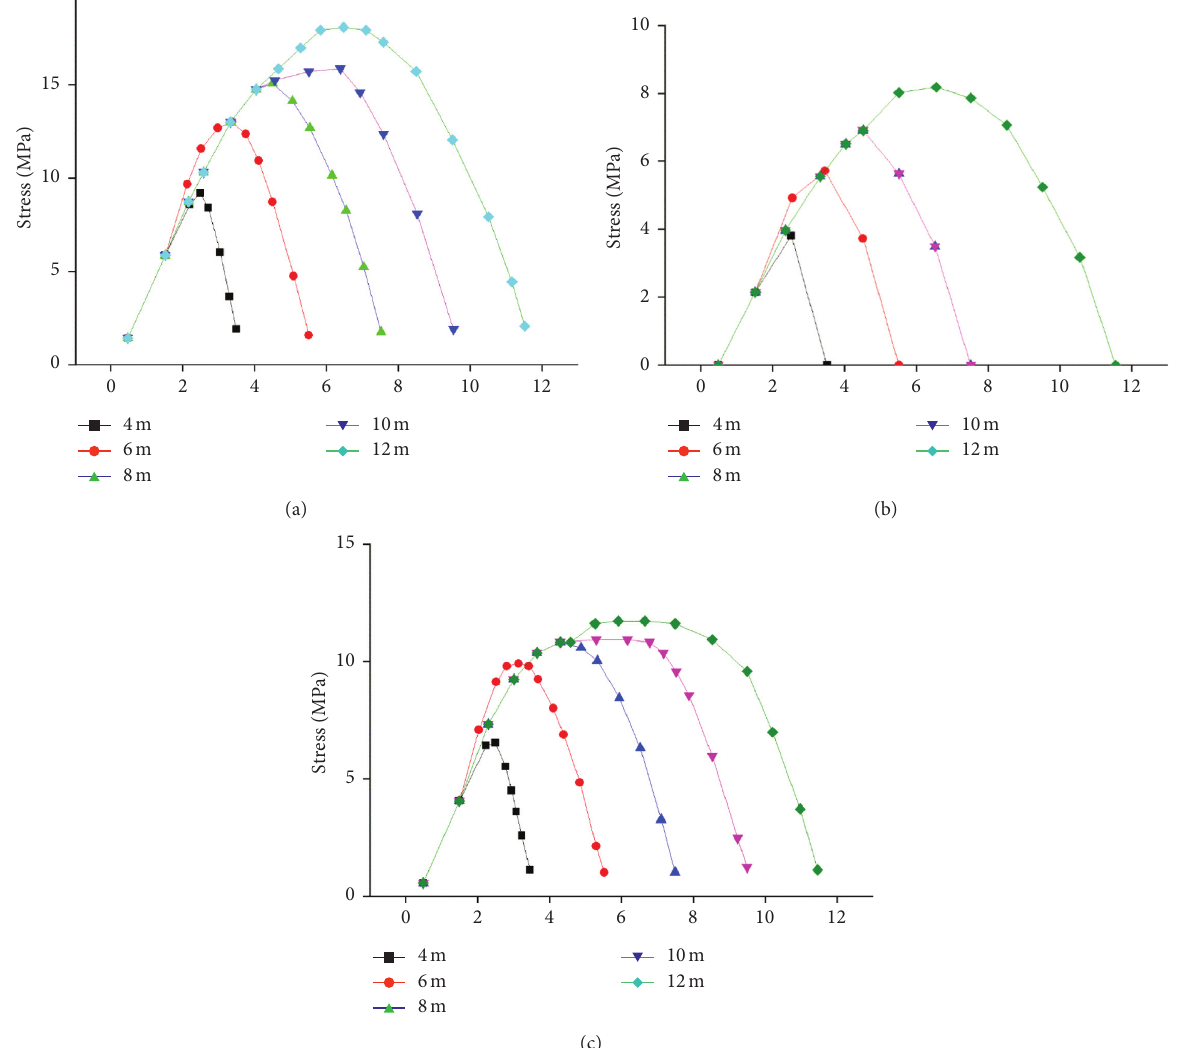
Figure 2: Stress distribution of the coal pillar in the gob-side entry. (a) Vertical stress. (b) Horizontal stress vertical to the axial location of the roadway. (c) Horizontal stress of the axial location of the